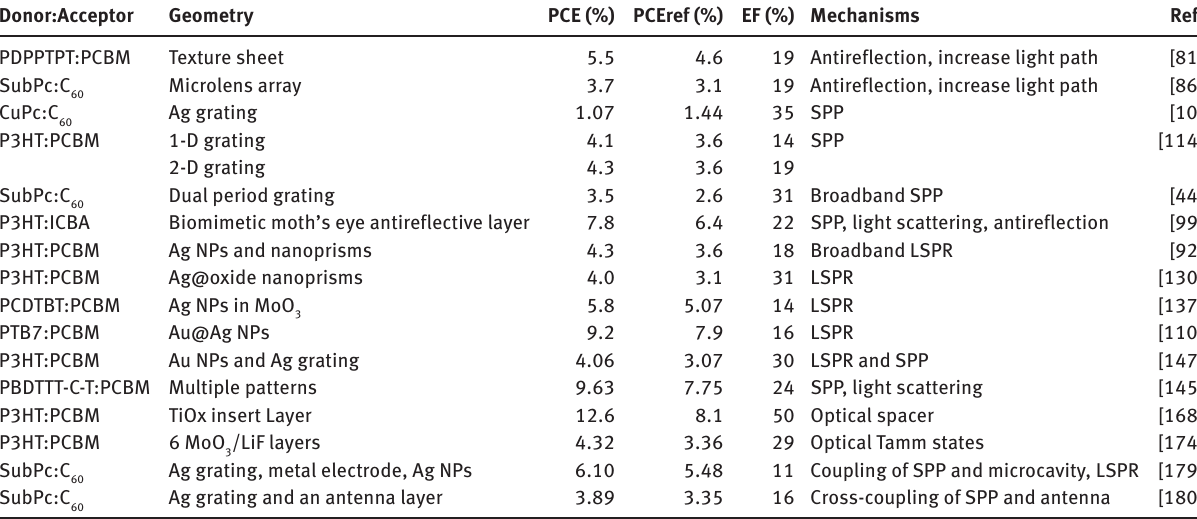
Table 2: The improved performance of OPVs by the nanopattern-induced light